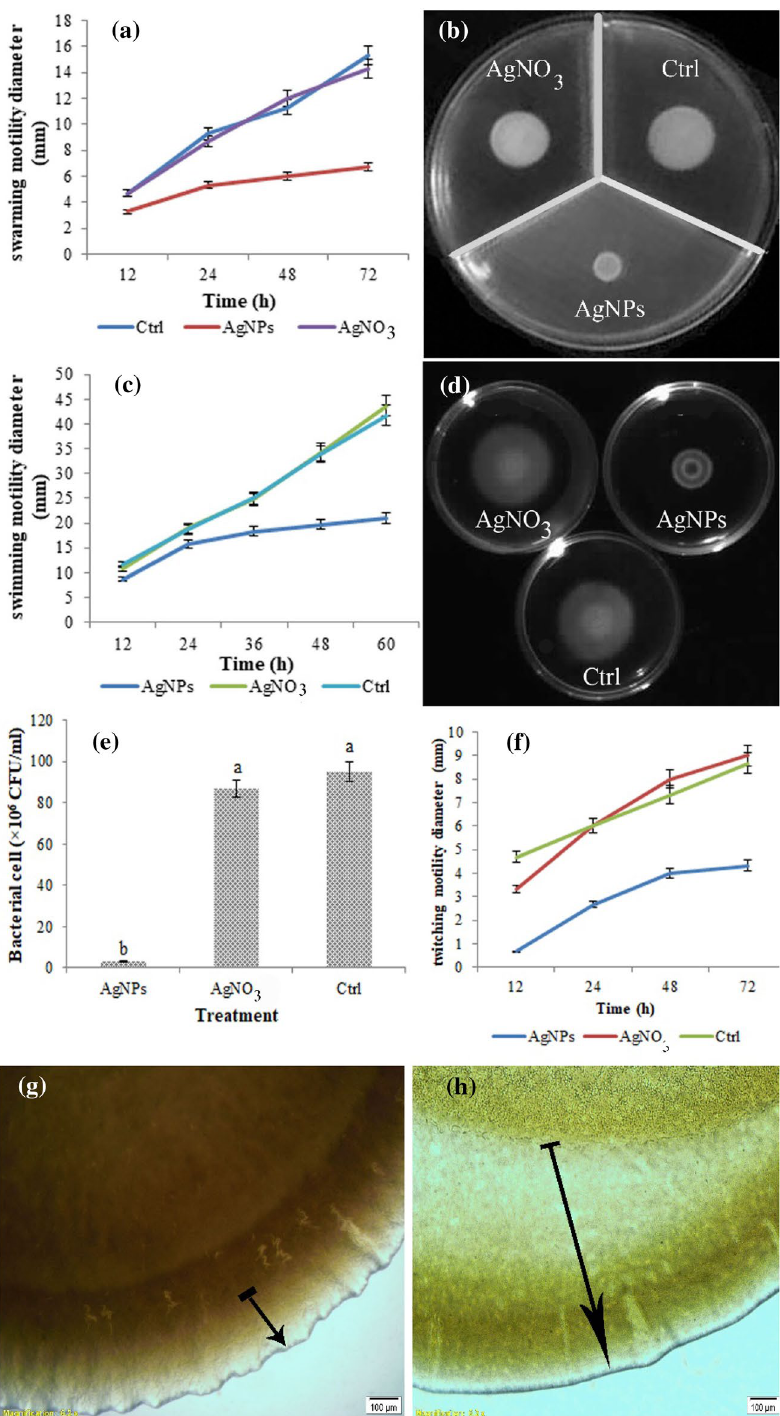
Figure 6. Effects of AgNPs biosynthesized by Pseudomonas canadensis Ma1 on various motilities of P. tolaasii Pt18 compared to the untreated control (Ctrl). ( a ) the diameter of the motility zone, and ( b ) a representative plate of the swarming motility assay, ( c ) the diameter of the motility zone, and ( d ) a representative plate of the swimming motility assay, ( e ) the chemotaxis behavior toward mushroom extract, ( f ) the diameter of twitching motility zone, and representative microscopic examination of the peripheral edge of twitching motility, ( g ) bacterial cells treated with AgNPs, ( h ) untreated control (Ctrl). Arrowheads indicate a twitching zone. Three replicates were used for each treatment. Error bars indicate the SE of the three replicates. Different letters indicate significant differences (p =